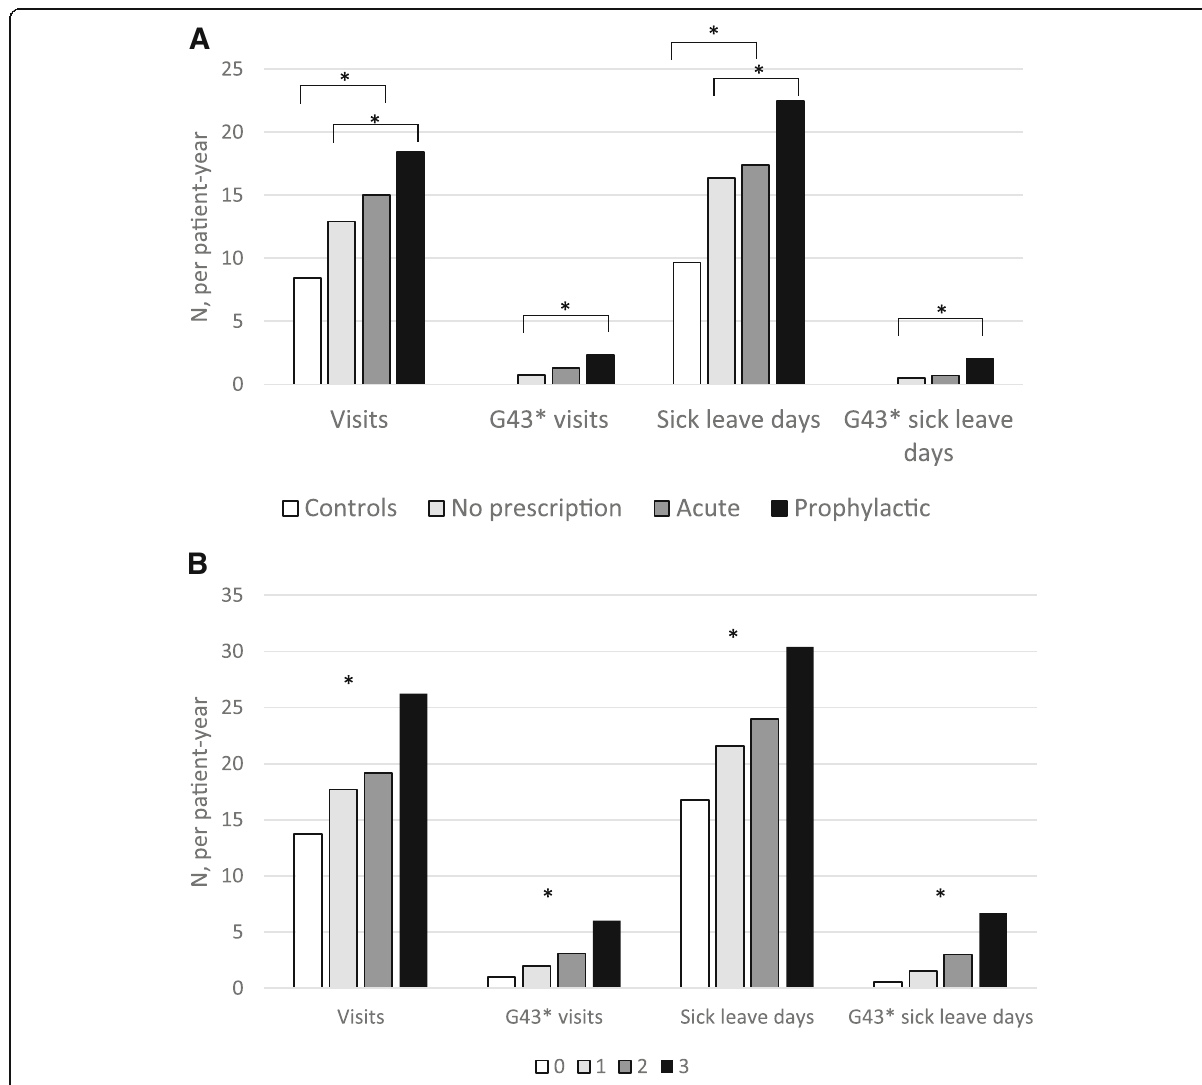
Fig. 3 a Overall and disease specific (G43*) visits and sick leave days per patient-year in controls (white) and the primary cohort [no prescriptions (grey), acute prescriptions (dark grey), prophylactic prescriptions (black)]. Significance in indicated between controls and migraine patients, as well as between migraine groups. b Overall and migraine specific visits and sick leave days per patient-year by prophylactic treatment line. No prophylactic prescriptions (white); 1st prophylactic treatment line (light grey); 2nd prophylactic treatment line (dark grey); 3rd or more treatment line (black). Significance is indicated between four groups. * p